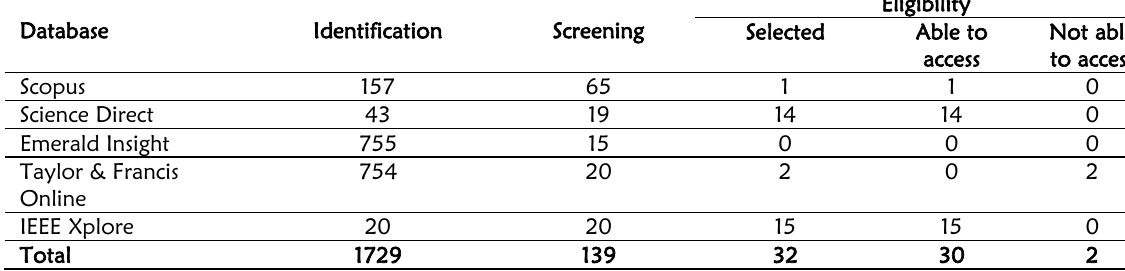
Table 10: Numbers of articles available to be access (additional keywords).